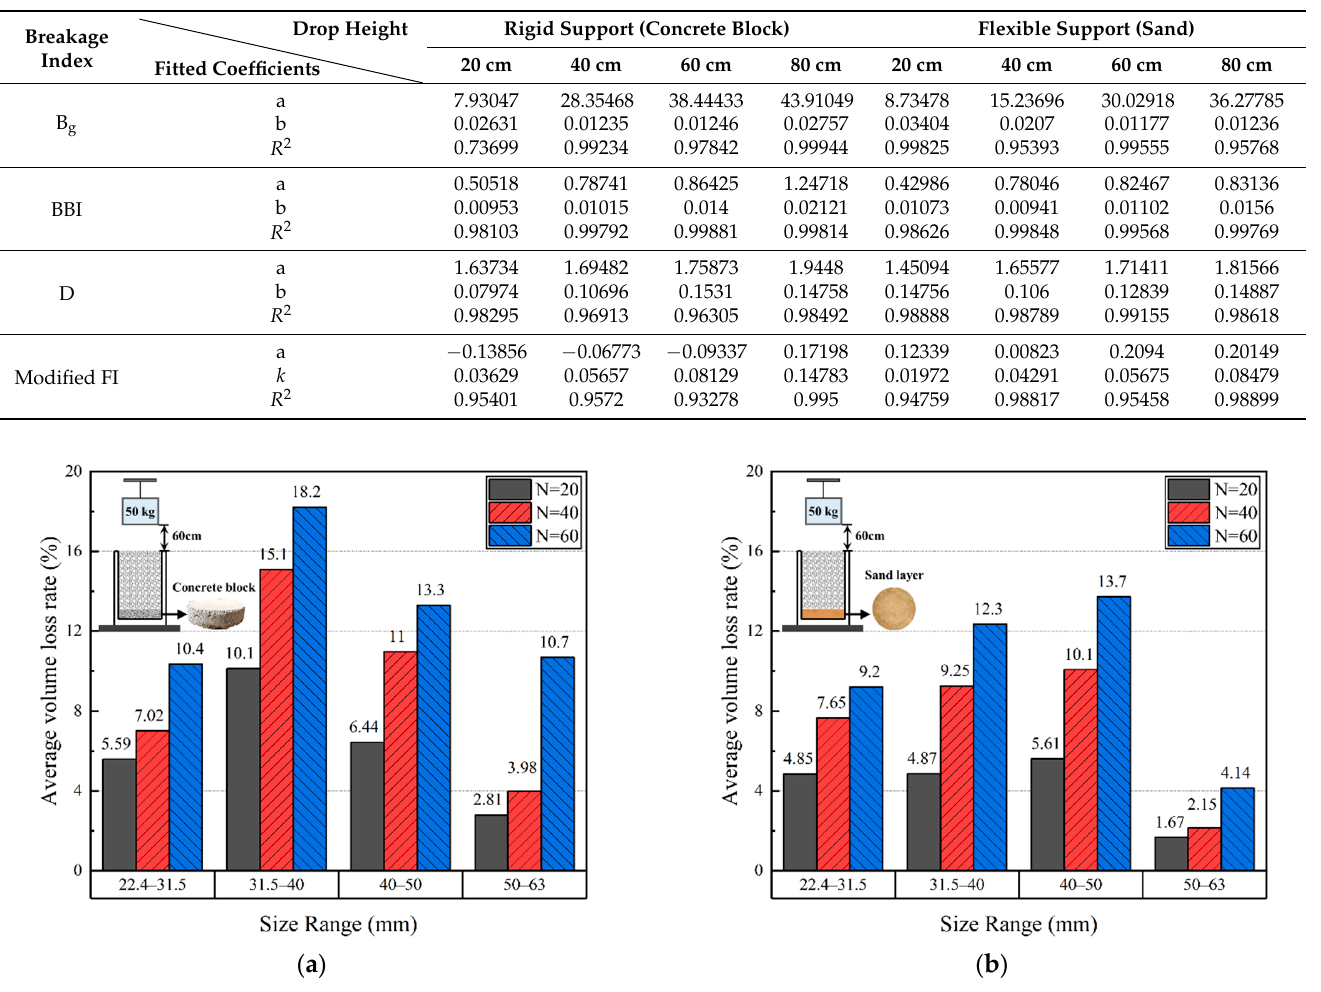
Figure 15. The histograms of average rates of volume reduction ( 𝜂 ) of particles within different size ranges of the multiple-size ballast specimens over ( a ) rigid and ( b ) flexible supports upon the completion of 20, 40, and 60 impact-load applications (N).